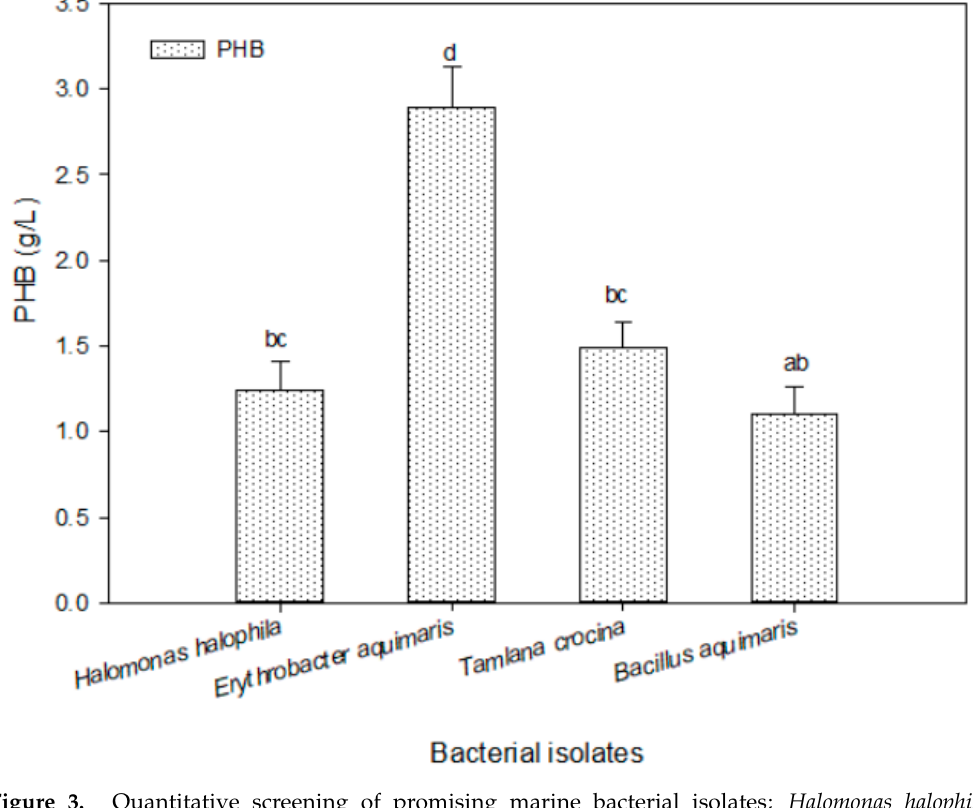
Figure 3. Quantitative screening of promising marine bacterial isolates; Halomonas halophila (KKU-MD12), Erythrobacter aquimaris (KKU-MD13), Tamlana crocina (KKU-MR35), and Bacillus aquimaris (KKU-MR42) for PHB production. The values set by oneself letter(s) on the same column were not significantly di ff